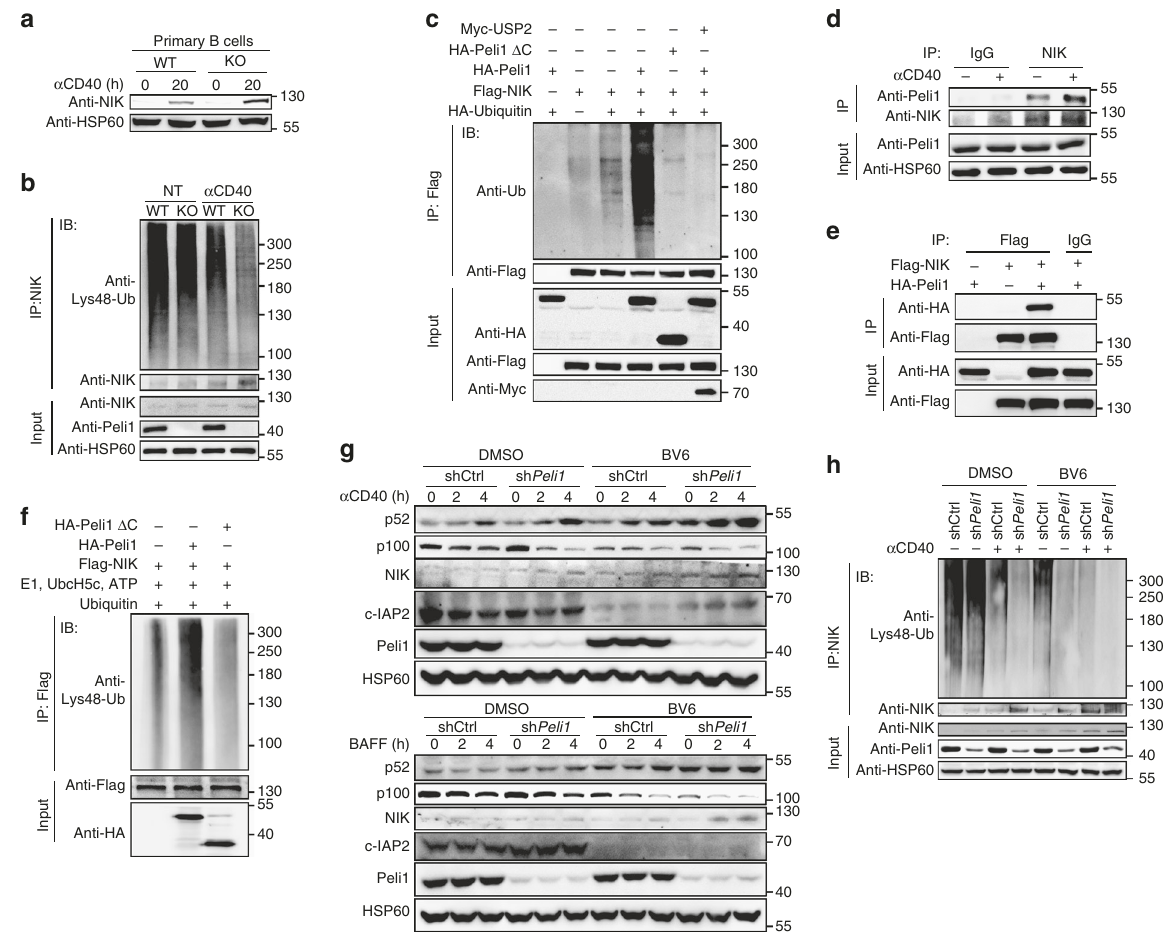
Fig. 6 Peli1 binds to and mediates Lys48 ubiquitination of NIK. a Immunoblot analysis of NIK and HSP60 in whole-cell lysates of WT and Peli1 -de fi cient splenic B cells stimulated with anti-CD40 ( α CD40). b Analysis of Lys48 ubiquitination of NIK in WT and KO B cells left unstimulated or stimulated with anti-CD40 ( α CD40) for 4 h in the presence of a proteasome inhibitor MG132. IP, immunoprecipitation; IB, immunoblotting. c Ubiquitination of NIK in HEK293 cells transfected with ( + ) or without ( − ) indicated expression vectors. d Immunoassays on lysates of WT splenic B cells left unstimulated or stimulated with anti-CD40 ( α CD40) for 4 h in the presence of MG132, followed by IP with control IgG or anti-NIK and immunoblot analysis of NIK- associated Peli1. e IP analysis examining the association of NIK with Peli1 in HEK293 cells transfected with ( + ) or without ( − ) indicated expression vectors. f Immunoblot analysis of Lys48 ubiquitination of NIK assessed by in vitro ubiquitination assay with a mixture of E1, E2 (UbcH5c), ATP, Flag-NIK, HA-Peli1, or HA-Peli1 Δ C after IP with anti-Flag. g Immunoblot analysis of p52, p100, NIK, c-IAP2, Peli1, and HSP60 in total lysis of control and Peli1 -knockdown M12 cells that pretreated with DMSO or smac mimetic BV6 for 4 h, and then stimulated with anti-CD40 ( α CD40) (upper panel) or BAFF (lower panel) at the indicated time points. Ctrl, control. h Analysis of Lys48 ubiquitination of NIK in control and Peli1 -knockdown M12 cells that pretreated with DMSO or smac mimetic BV6 for 4 h, then left unstimulated or stimulated with anti-CD40 ( α CD40) for 4 h in the presence of MG132. Ctrl, control. Data are shown based on three independent